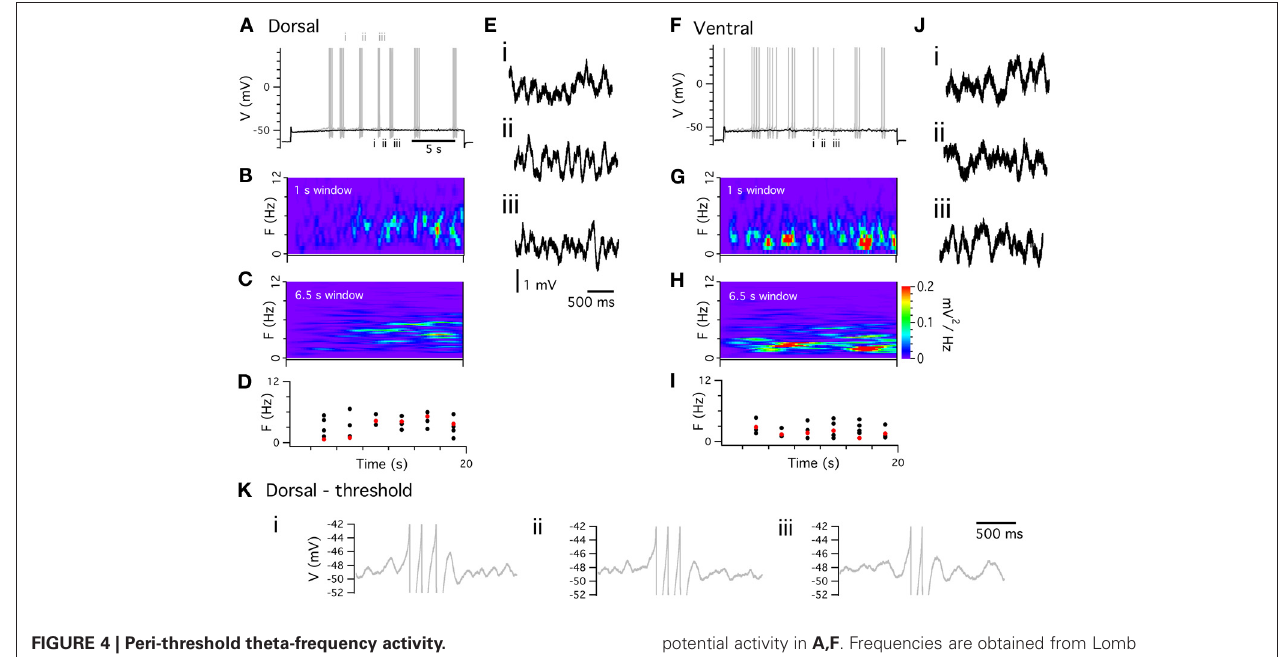
potential activity in A,F . Frequencies are obtained from Lomb periodograms of contiguous 3s segments of data. (E,J) Examples of consecutive 2s segments of data from peri-threshold activity in A,F (K) Examples of 1.5s segments of membrane potential activity triggered by final spikes of three consecutive clusters of action potentials in A . Note the different frequency of the theta activity following each spike